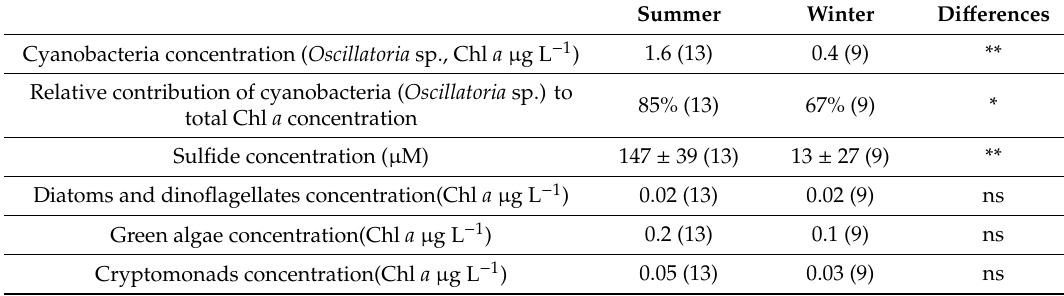
Table 1. Di ff erences among cyanobacteria, diatoms, dinoflagellates and green algae concentration (Chl a µ g L − 1 ) during summer and winter (Mann–Whitney Rank Sum Test, median). The relative contribution of Oscillatoria sp. to total Chl a concentration, and the comparison between winter and summer sulfide concentration ( t -student, mean ± standard deviation), is shown as well. Numbers in brackets indicate numbers of replicates, * p < 0.005, ** p < 0.001, ns indicates non-significance.